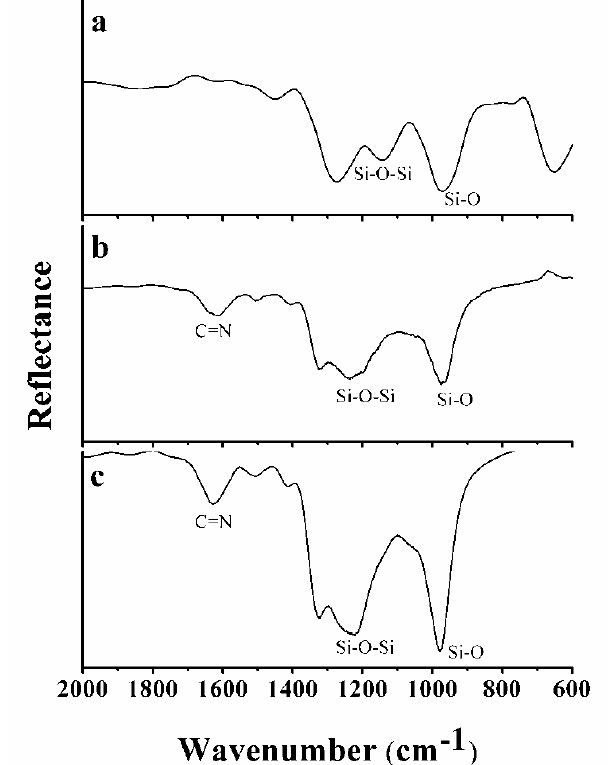
( c ) Si N functionalised with 3 4